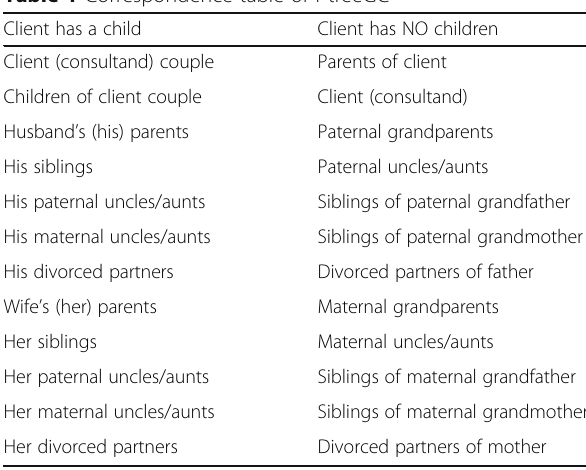
Table 1 Correspondence table of